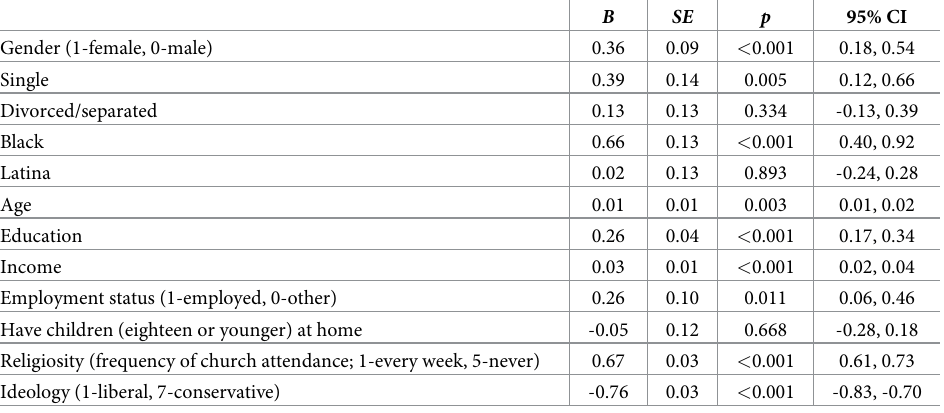
Table 1. Linear regression predicting legal abortion support among men and women. B SE p 95% CI Gender (1-female, 0-male) 0.36 0.09 < 0.001 0.18, 0.54 Single 0.39 0.14 0.005 0.12, 0.66 Divorced/separated 0.13 0.13 0.334 -0.13, 0.39 Black 0.66 0.13 < 0.001 0.40, 0.92 Latina 0.02 0.13 0.893 -0.24, 0.28 Age 0.01 0.01 0.003 0.01, 0.02 Education 0.26 0.04 < 0.001 0.17, 0.34 Income 0.03 0.01 < 0.001 0.02, 0.04 Employment status (1-employed, 0-other) 0.26 0.10 0.011 0.06, 0.46 Have children (eighteen or younger) at home -0.05 0.12 0.668 -0.28, 0.18 Religiosity (frequency of church attendance; 1-every week, 5-never) 0.67 0.03 < 0.001 0.61, 0.73 Ideology (1-liberal, 7-conservative) -0.76 0.03 < 0.001 -0.83, -0.70 N = 3,785 (675 observations were deleted due to missing data); CI–Confidence